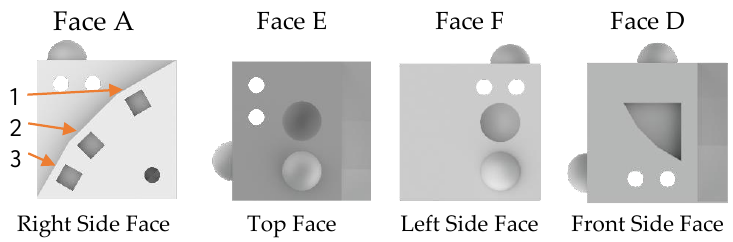
Figure 2. Sample Faces Subjected to Roughness Measurement.